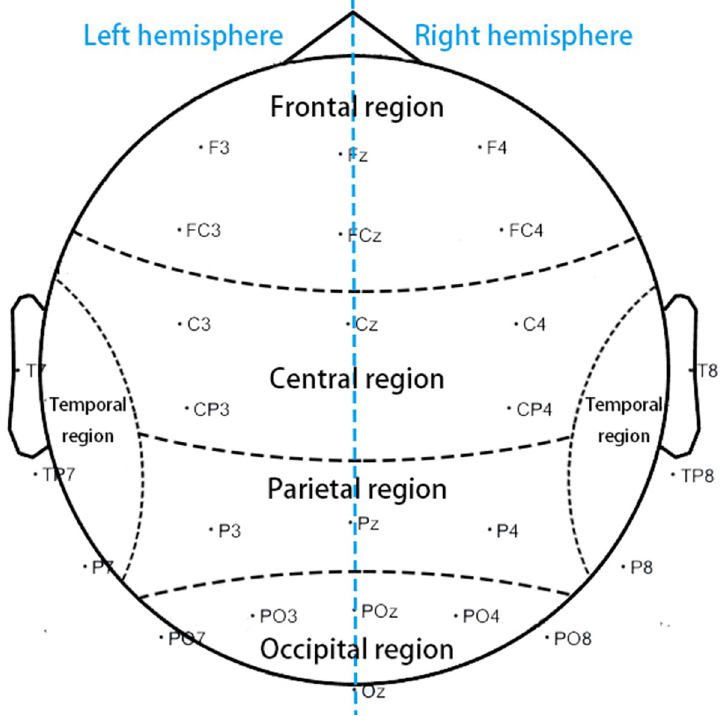
Fig 8. Layout of the locations of the EEG scalp electrodes on brain regions. Five groups of EEG scalp electrodes representing five brain regions: frontal, parietal, central, temporal, and occipital.